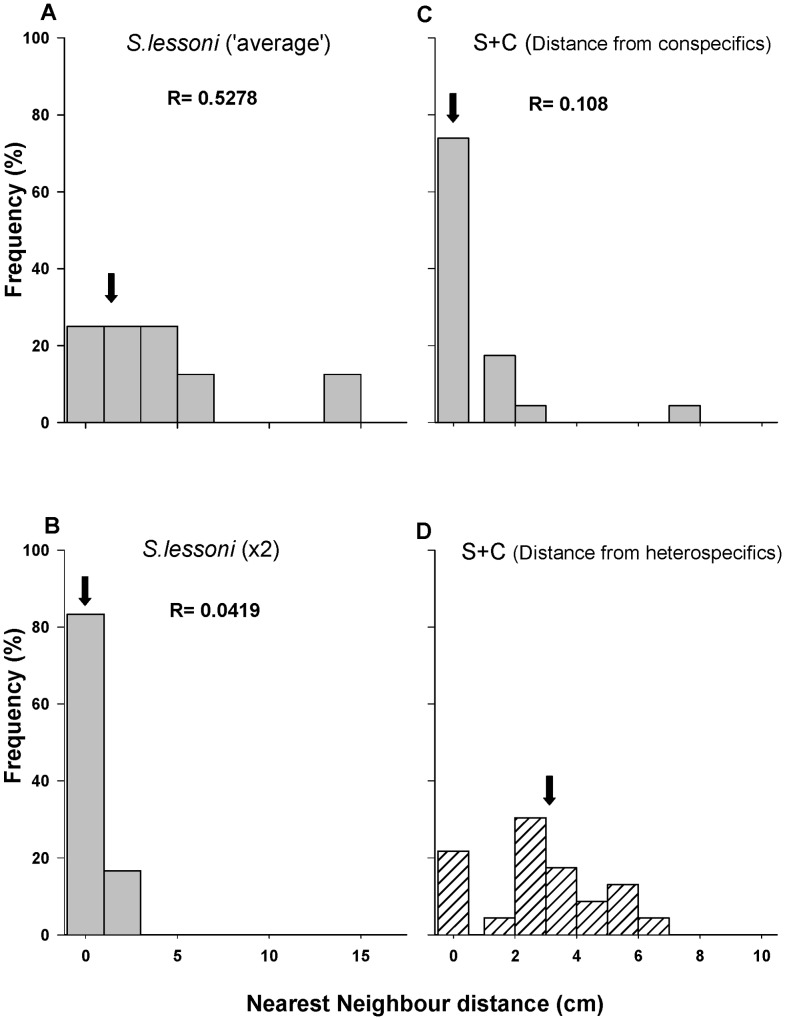
Nearest neighbor linear distances histogram for Siphonaria lessoni, recorded in laboratory experiments.Distances to conspecifics (a-c) and heterospecific (d) in intraspecific enclosure treatments at ‘average’ (a) and double density (b), and in interspecific (c, d) enclosure treatments (i.e. distance from C. granosus). Arrows show the median value. The R statistic estimate if the distributional pattern is dispersive (R = 2.0), aggregated (R = 0.0) or uniform (R = 1.0).